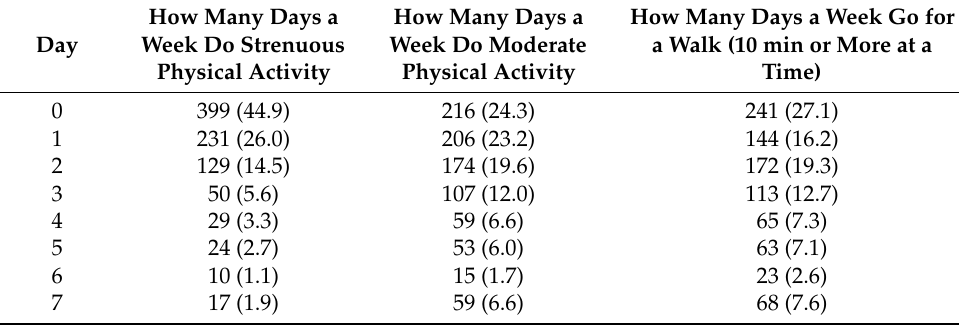
Table 3. Physical activity during the “stay-at-home”